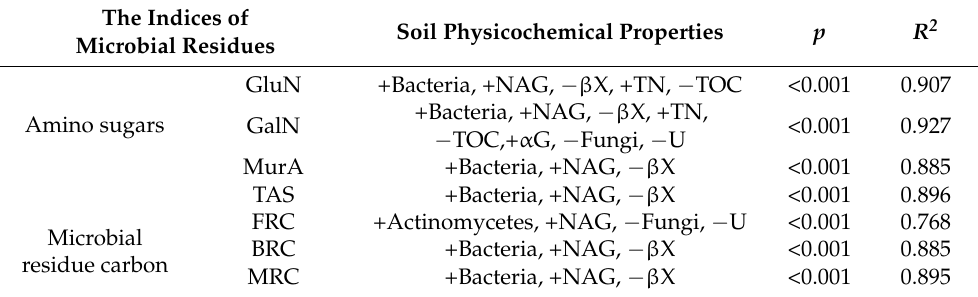
Table 3. Stepwise regression analysis between soil microbial residues and soil physicochemical properties within